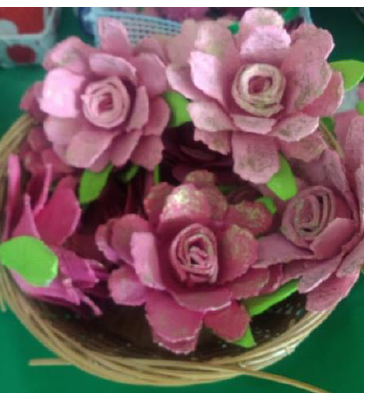
Photograph 7: Craft flowers made from pasta. Photograph taken by author. April,